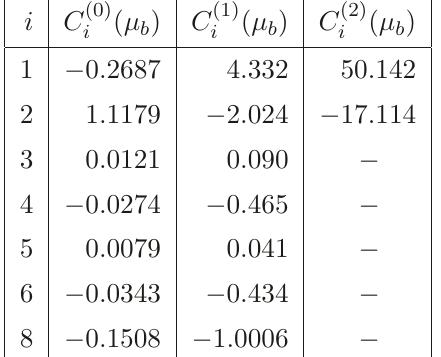
Table 2 . The LO, NLO and NNLO Wilson coefficients C ( k ) α s ( ¯ m b ) = 0 . 226 (implementing the formula of ref. [42] with QED effects set to zero) and the matching scale µ 0 = M W . We have used ref. [29] to compute C ( k )